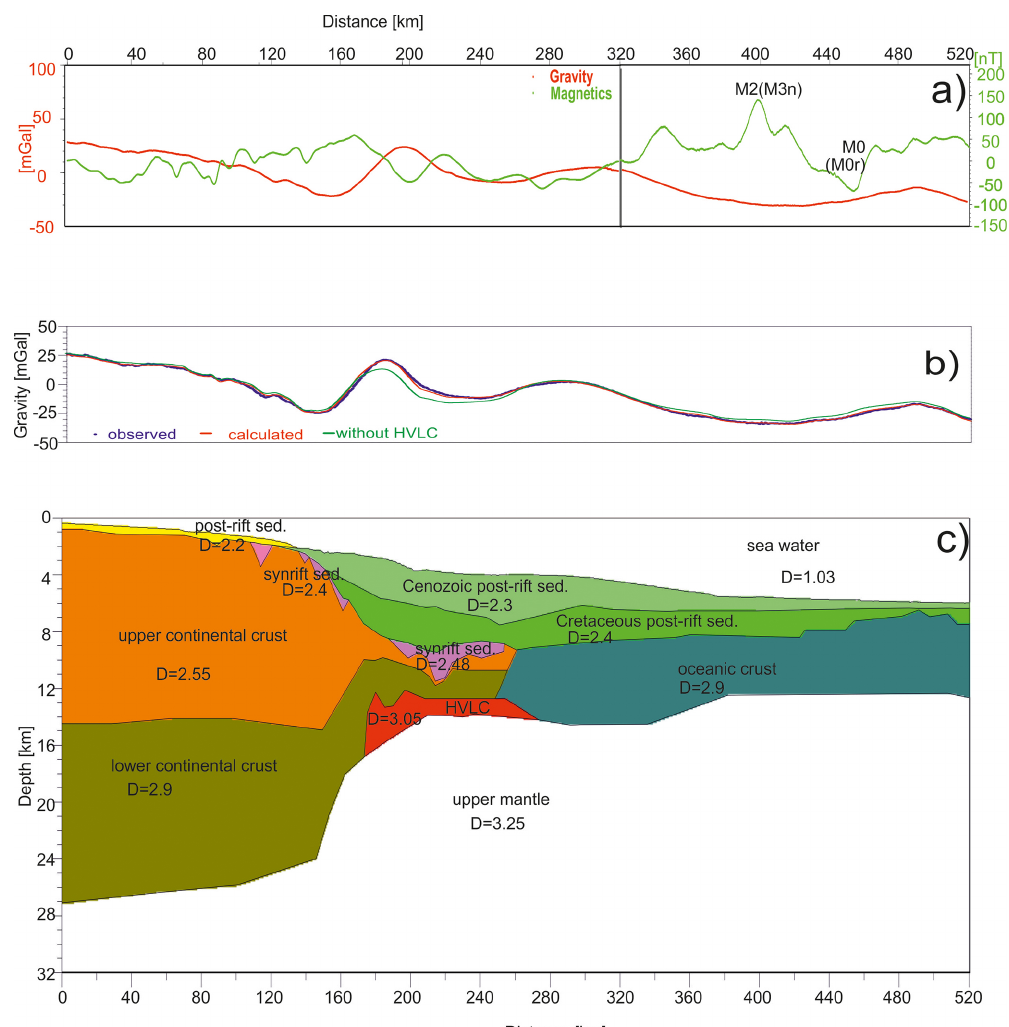
Figure 6. Two-dimensional gravity model of the southernmost line 3 from the western margin as adopted from velocity modeling. (a) Observed gravimetric (red) and magnetic (green) data with interpreted magnetic anomalies M2 and M0. (b) Observed (blue) and calculated (red) gravity curves shown for the gravity model. The green line displays the curve for a gravity model without an HVLC body. (c) Result of 2-D gravity modeling showing an abrupt thinning of the continental crust when approaching the oceanic domain. The density values are given in gcm − 3